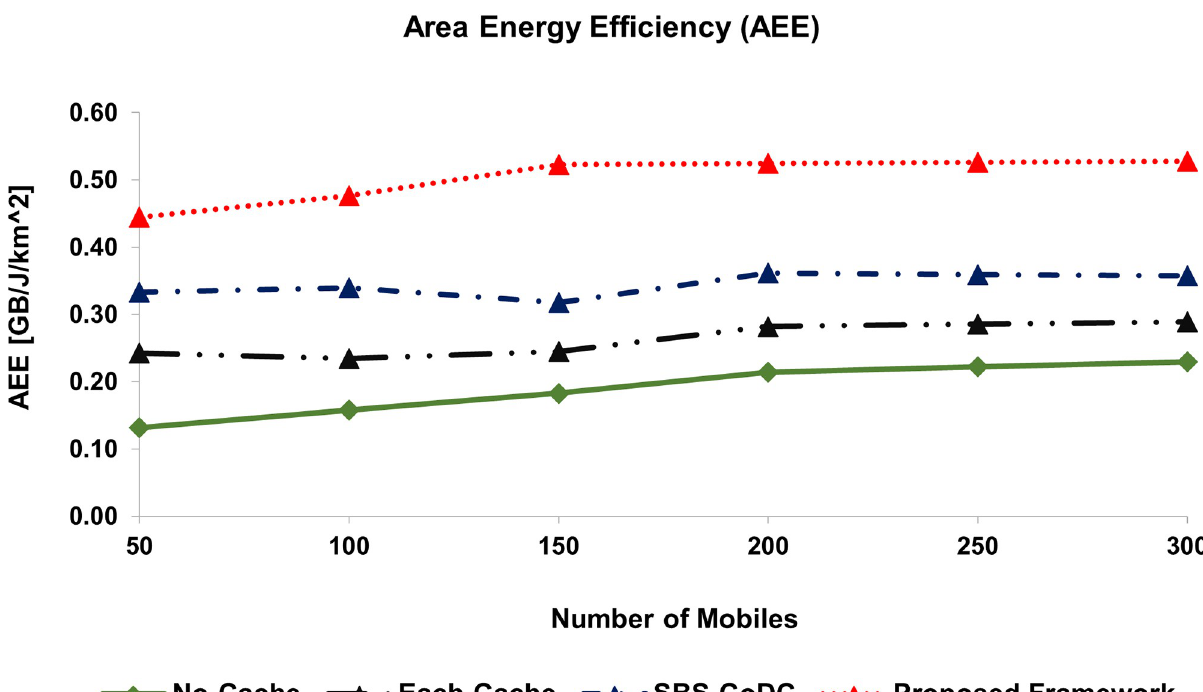
Fig 13. Comparison AEE based on coverage area and EE.